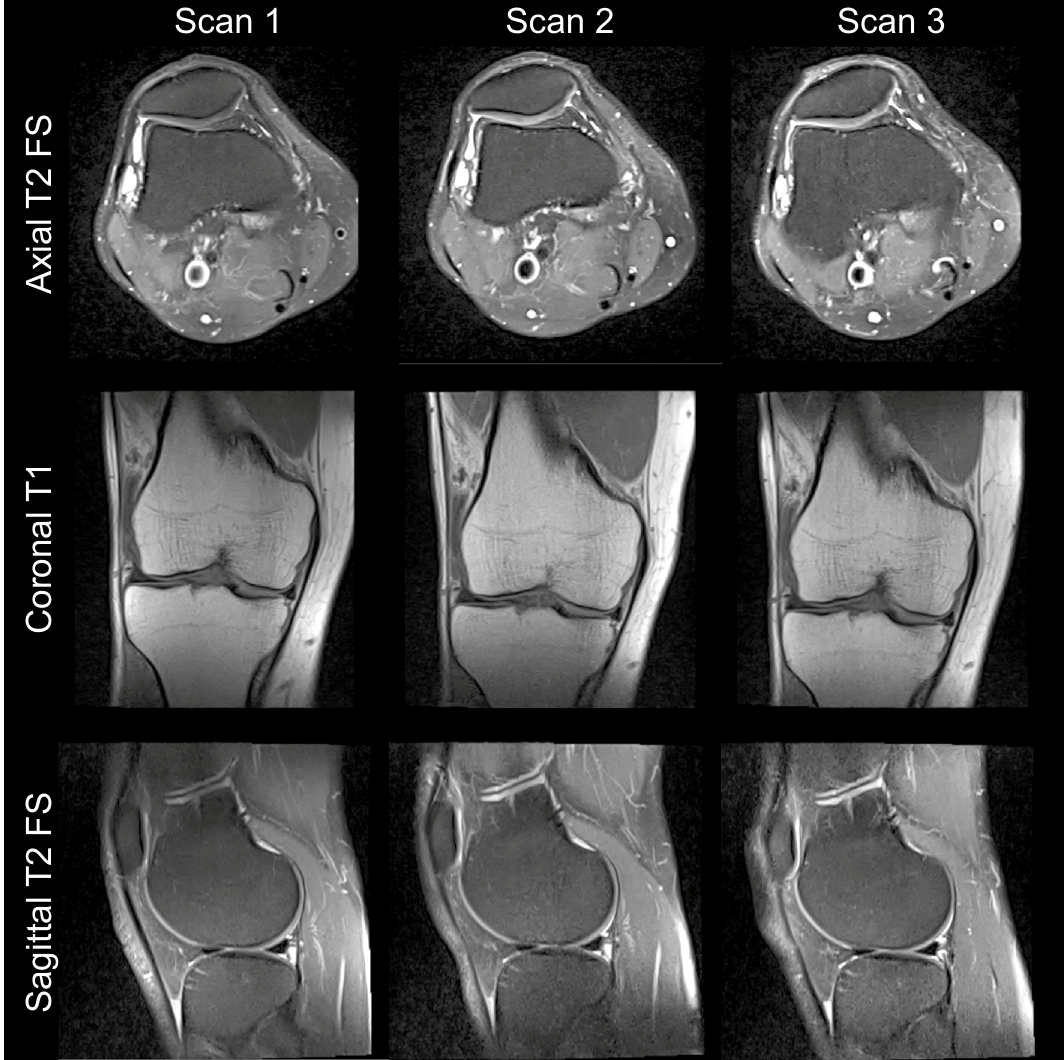
Figure 16. Turbo spin echo MR images from a 31-year-old man acquired with the 0.55 T cable coil during three separate scan sessions on the same